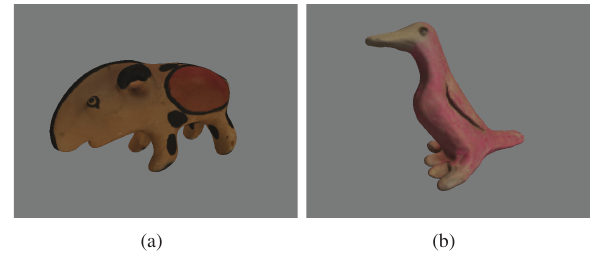
Fig. 3. 3D models of artifacts manufactured by two Brazilian indigenous communities: (a) Wauja and (b) Karaja.